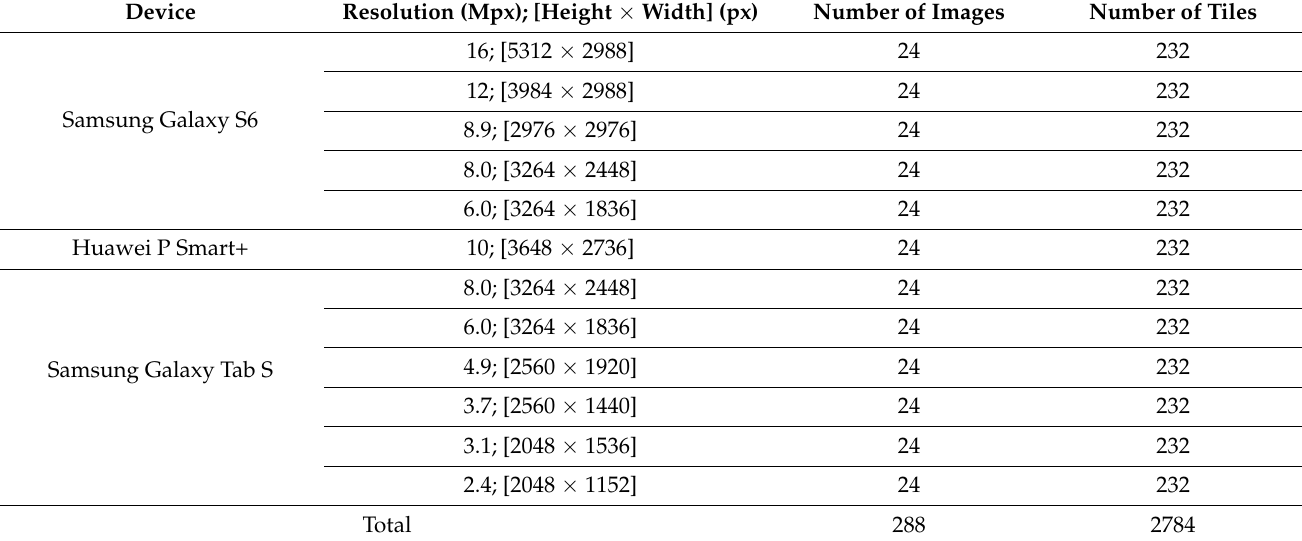
Table 3. Specifications of the tactode_small test